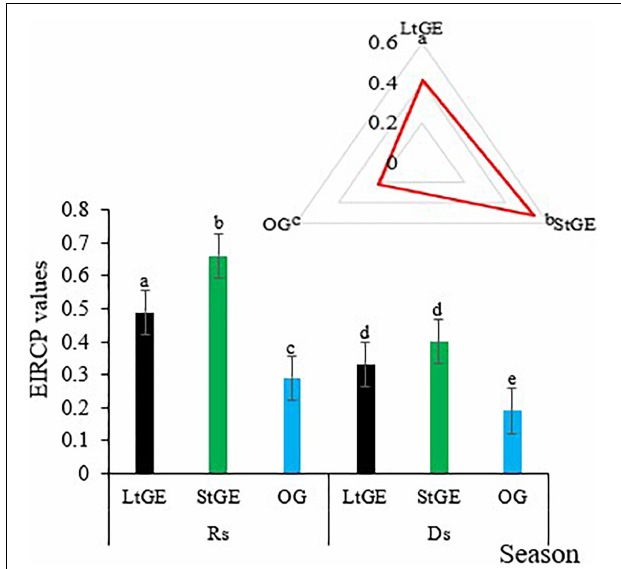
FIGURE 4 | Grass species’ phenological difference at grazing enclosure vs. open-grazing sites. Note. LtGE, long-term grazing enclosure; StGE, short-term grazing enclosure; OG, open-grazing; Rs, rainy season; Ds, dry season. Bar plots show seasonal variations and radar plots attached show the yearly average value. Error bars are shown by standard error. Different lowercase letters within bar and radar plots indicate differences with a significant level ( P < 0.05) between the